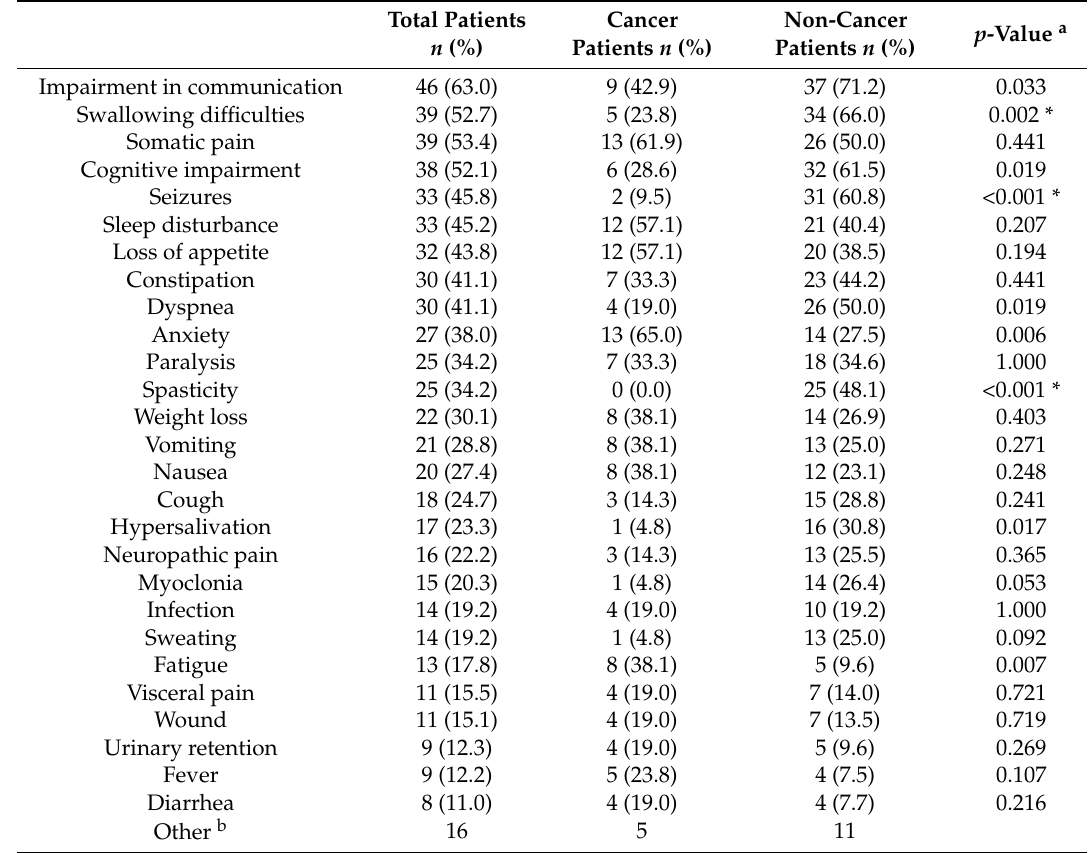
Table 4. Symptoms in cancer and non-cancer